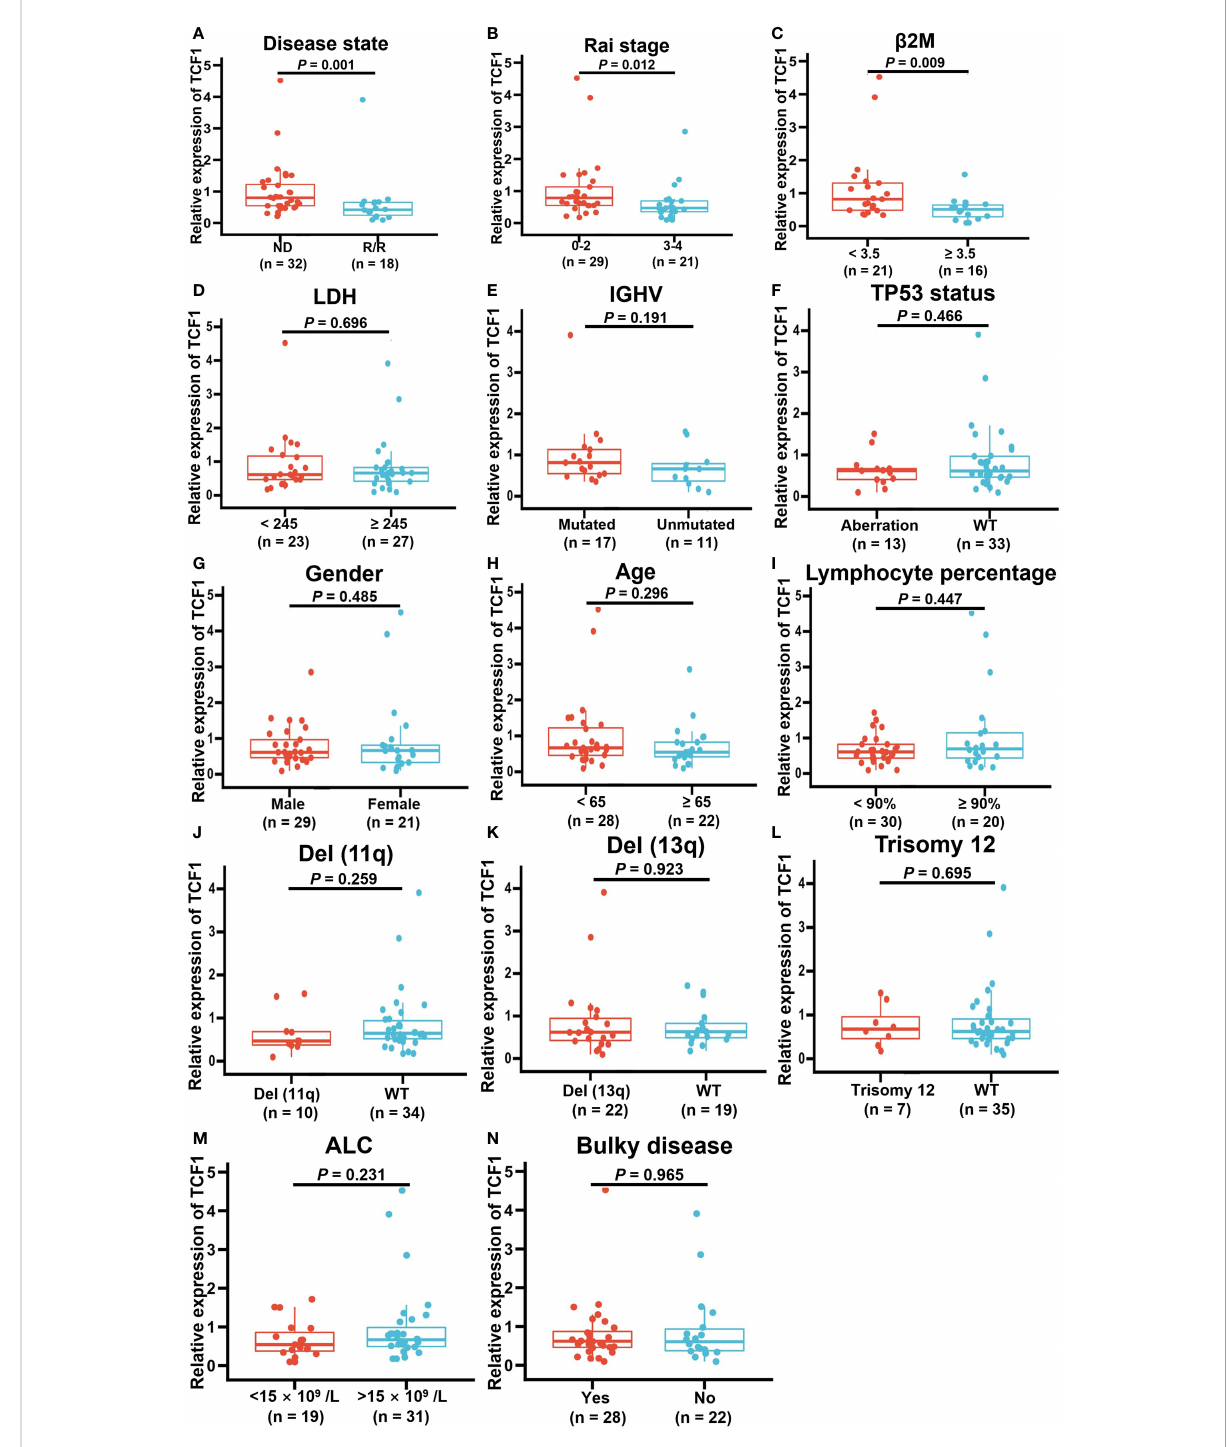
FIGURE 5 Correlation between decreased TCF1 expression and clinical factors in CLL patients. The correlation of TCF1 expression and various clinical characteristics, such as (A) newly diagnosed (ND) and relapsed/refractory (R/R) patients, (B) Rai stage 0-2 and 3-4, (C) b 2M < 3.5 or ≥ 3.5 (mg/L), (D) LDH < 245 or ≥ 245 (IU/L), (E) IGHV mutated and unmutated, (F) TP53 aberration or WT, (G) Male or female CLL patients, (H) < 65 or ≥ 65 years old, (I) Lymphocyte percentage, (J) Del(11q) or WT, (K) Del(13q) or WT, (L) Trisomy12 or WT, (M) ALC < 15 ×10 9 /L or >15 ×10 9 /L, and (N) Bulky or no. WT means wild type. Del means deletion. Error bars indicate